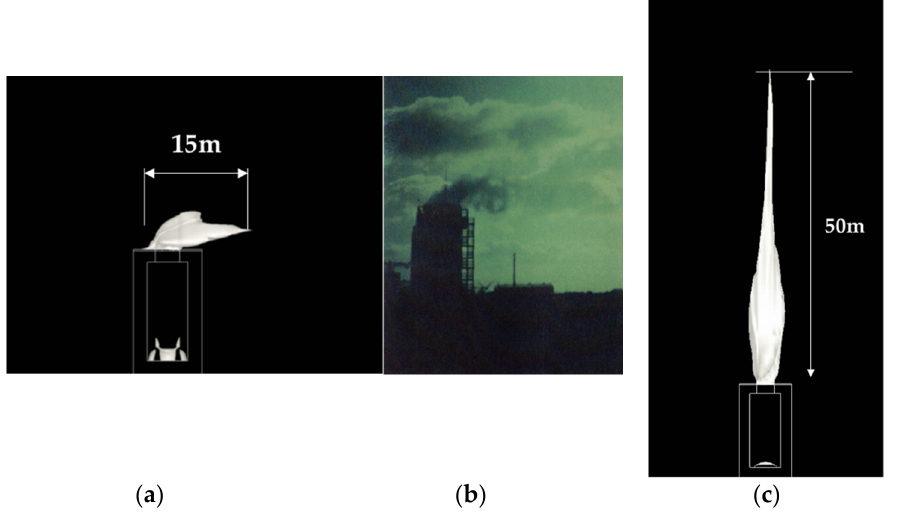
Figure 7. Comparisons of ( a ) calculated and ( b ) observed visible plumes with external wind, and ( c ) the calculated visible plume without external wind. ( c ) the calculated visible plume without external